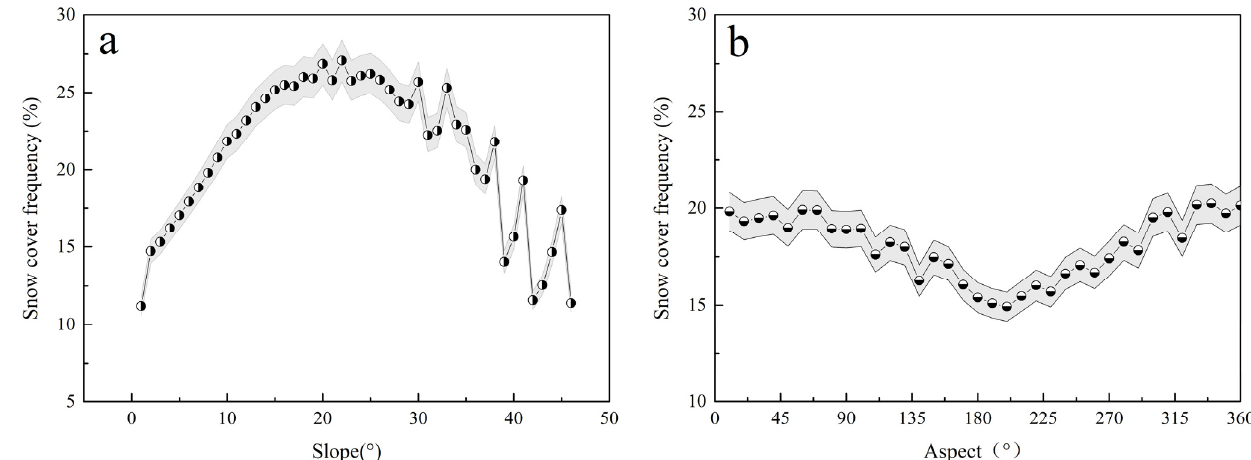
Figure 5. Correlation between annual SCF and ( a ) slope and ( b ) aspect during 2000–2020.